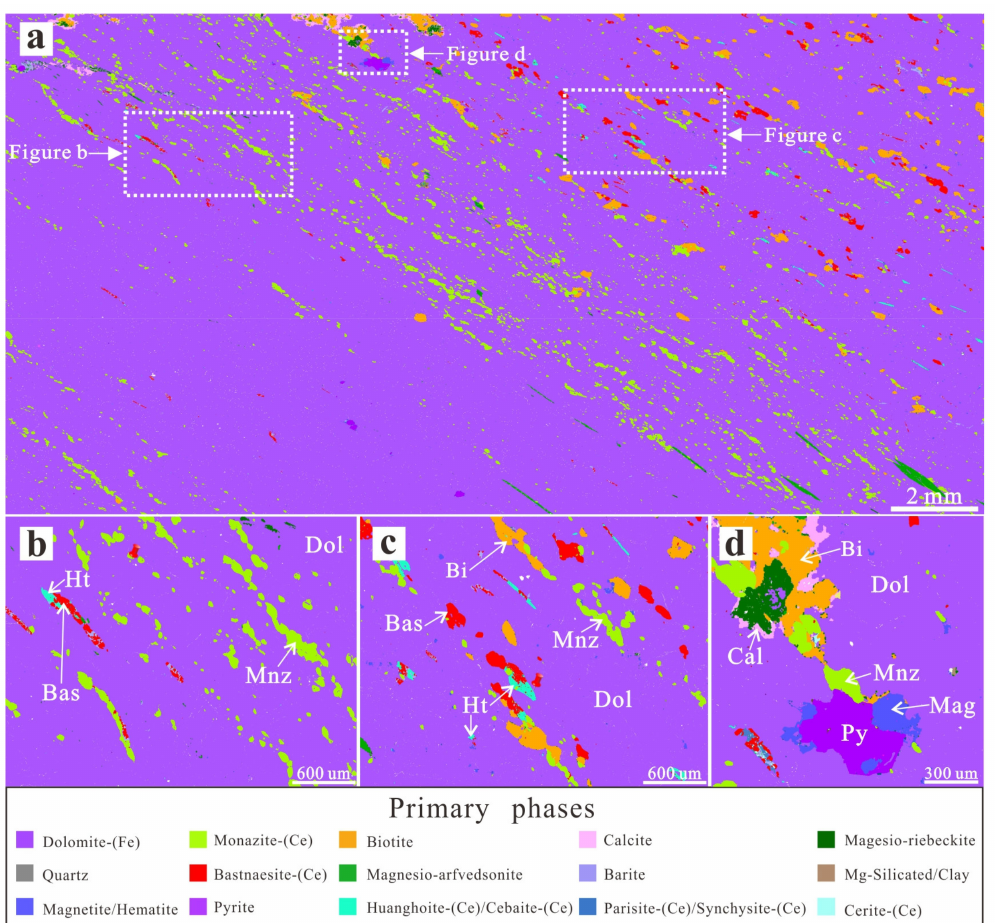
Figure 9. The TIMA false-colored mineral phase map of the 1682 m drill ore sample. ( a ) the whole image of the thin section shows banded ore texture; ( b – d ) close-up photos showing the mineralogy assemblage of the hydrothermal REE veins. Abbreviations: Dol, dolomite-(Fe); Bas,